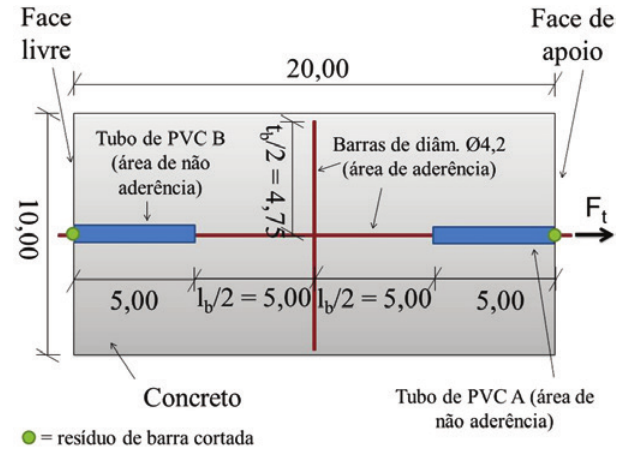
Figura 3 CP tipo "Tela" (corte